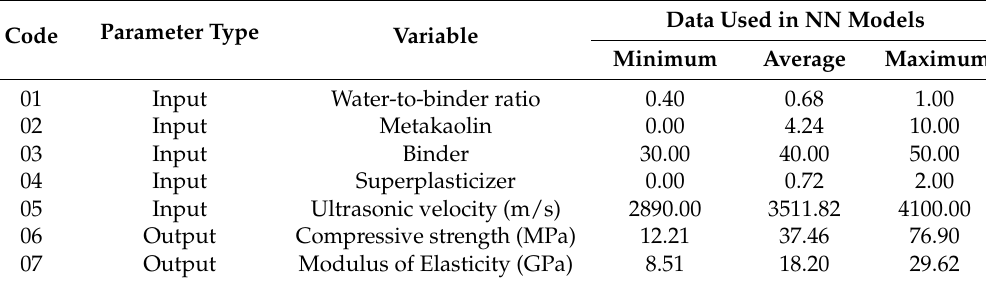
Table 2. The input and output parameters used in the development of